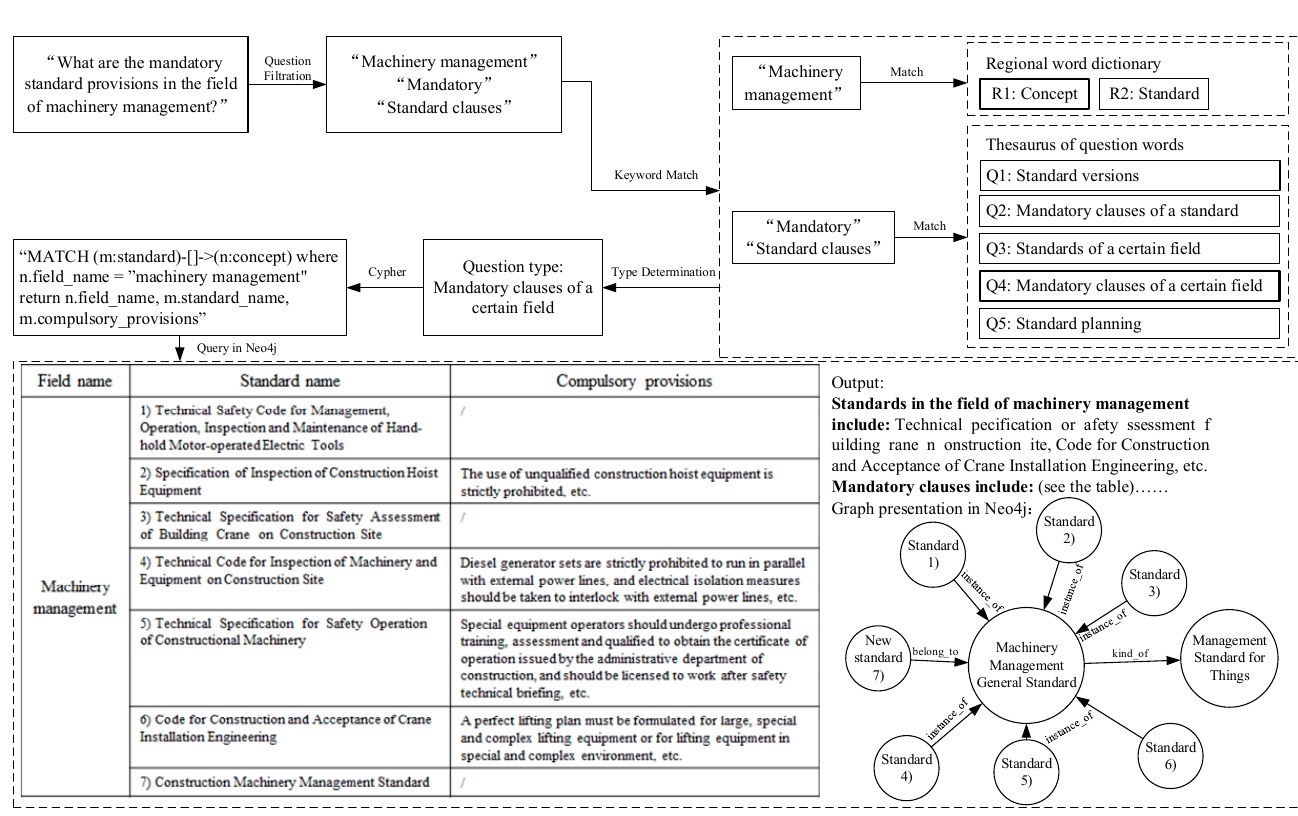
Figure 4. Q&A function of KGCSS.